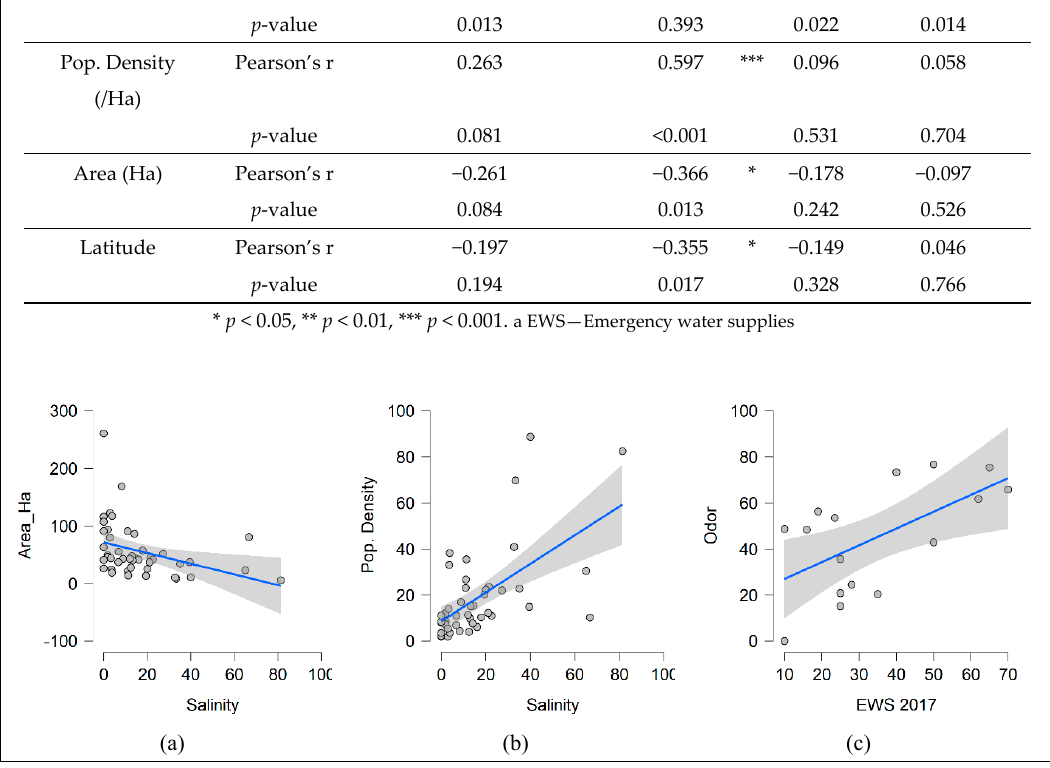
Figure 7. ( top ) There are the statistically significant relationships of Salinity with island area (negative), the total volume of emergency water supplied to the island in 2017 (EWS 2017, positive), population density (positive) and Latitude (negative). The presence of odor correlates with emergency water supply amounts. ( bottom ) Scatterplots of some of those significant relationships. ( a ) Salinity vs area of the island ( b ) salinity vs population density; ( c ) Emergency water supply (EWS) in 2017 vs Odor.